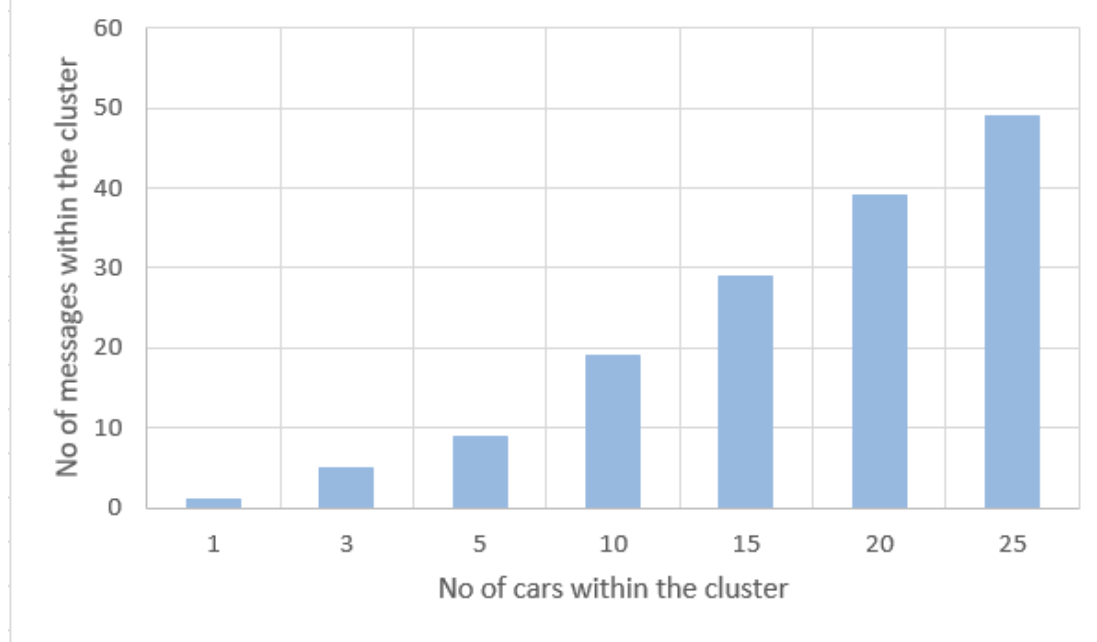
Figure 11. No of messages within the cluster/no of cars within the